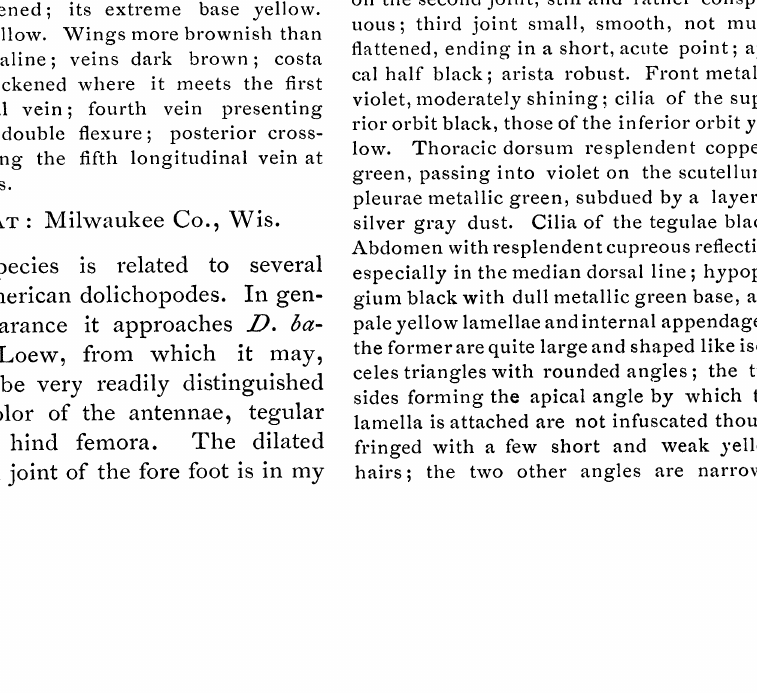
longitudinally coextensive with the black coloring; hind tarsi black, metatarsal joint a little thickened; its extreme base yellow. Halteres yellow. Wings more brownish than grayish hyaline; veins dark brown